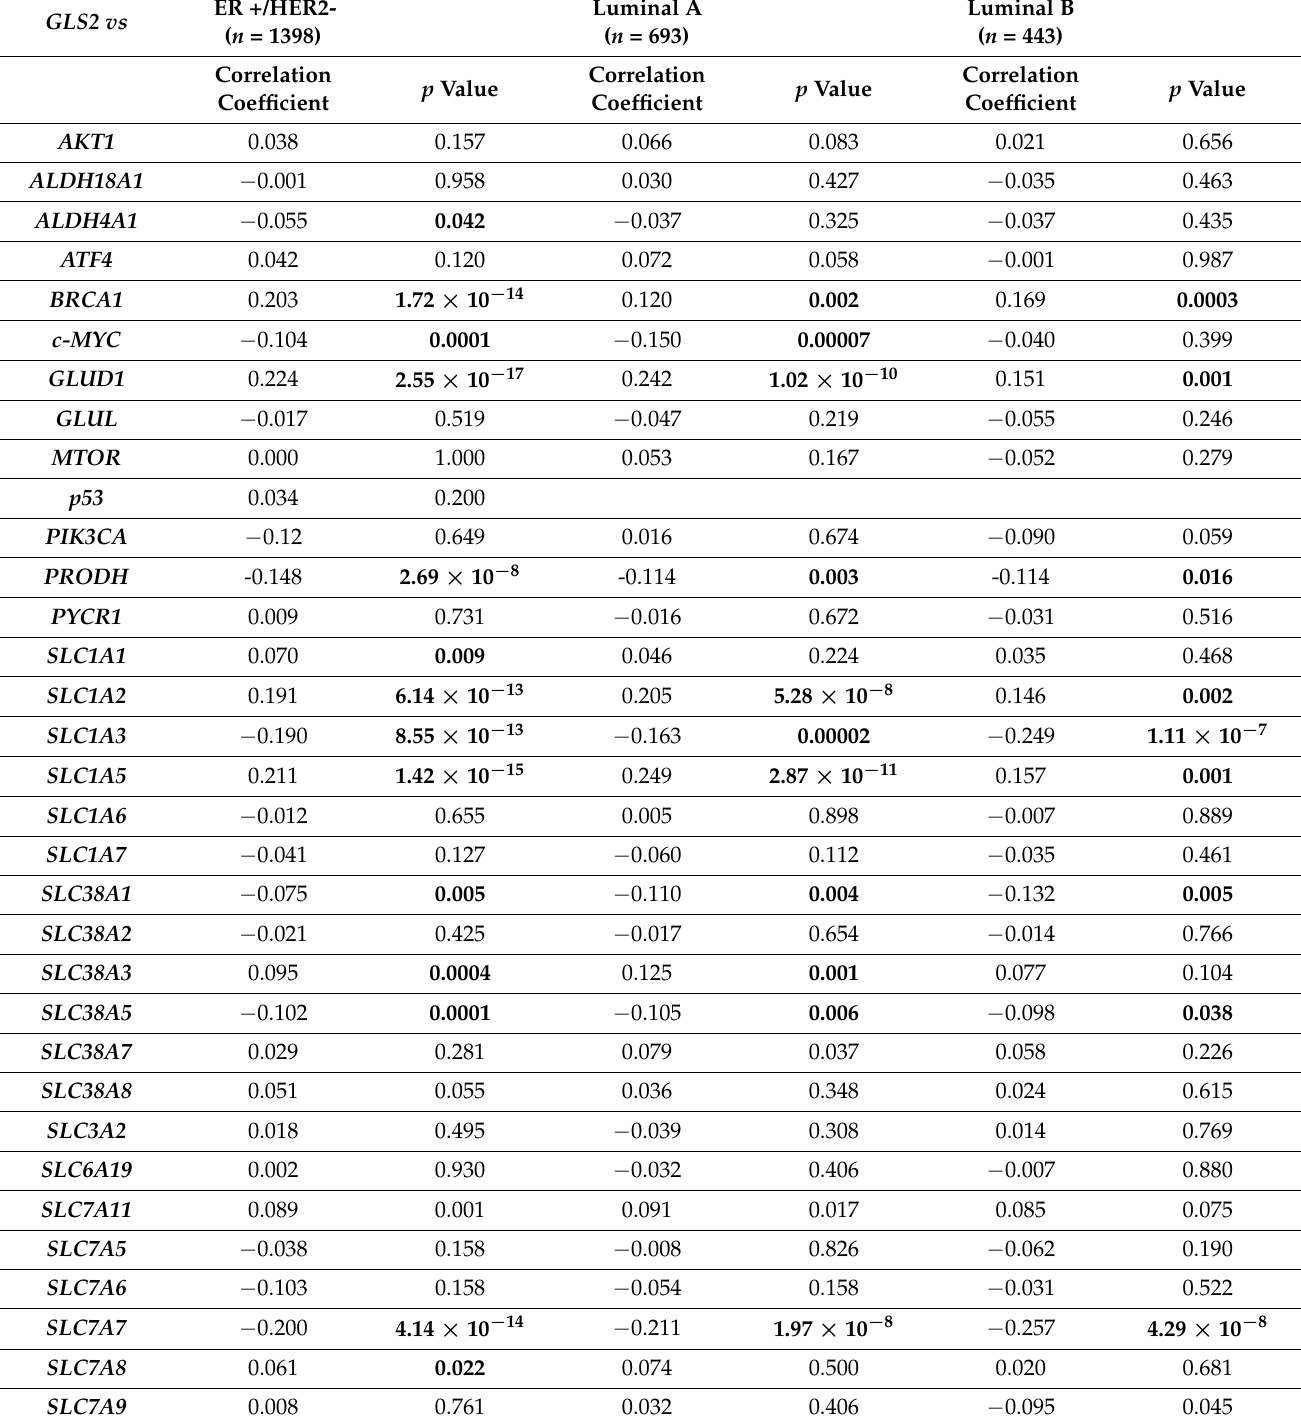
Table 2. Correlation of GLS2 mRNA expression with glutamine-metabolism-related mRNA in invasive luminal breast cancer. GLS2